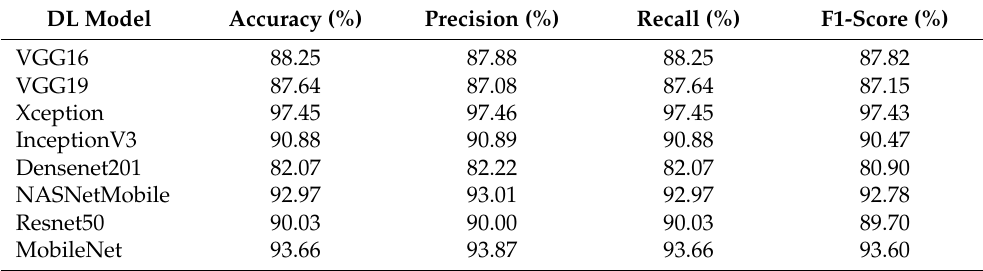
Table 2. The weighted average of performance metrics by eight different deep learning models for five-class classification of segmented chest X-ray images into COVID-19, VP, BP, TB, and normal.